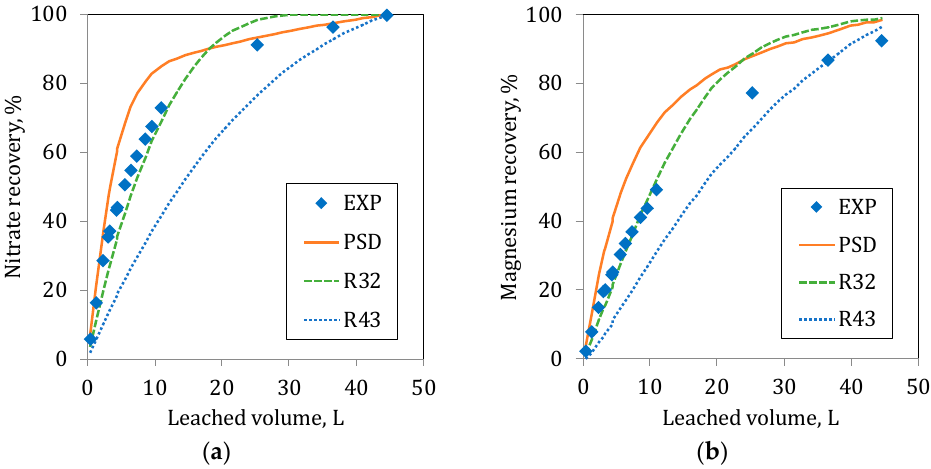
Figure 9. Simulated recoveries for column C20. ( a ) Nitrate and ( b ) Magnesium, using the radii of Table 6. Markers represent the experimental data, the solid line is the Particle Size Distribution (PSD), the dashed line is R32 and the dotted line is R43.